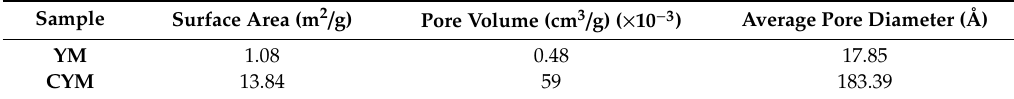
Table 1. Specific surface area (SSA) of YM